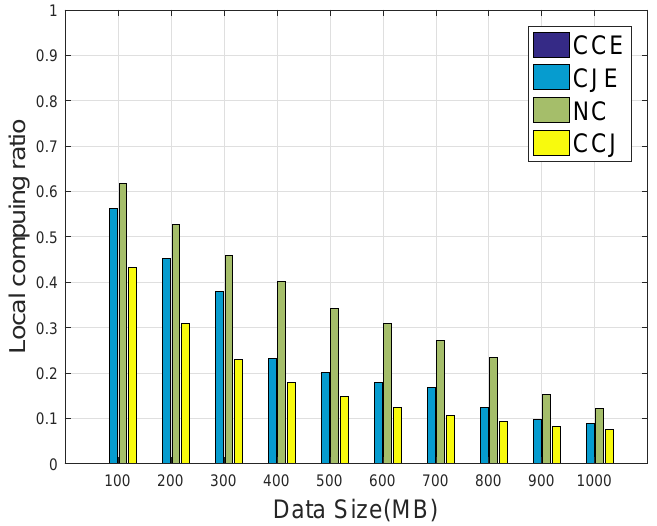
Figure 7. Average energy consumption on the four schemes versus the data size d k